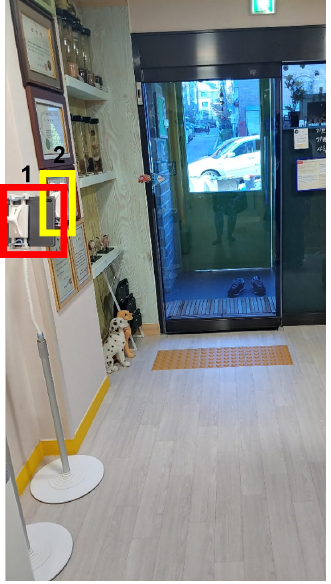
Figure 10. Installation of the camera indoors